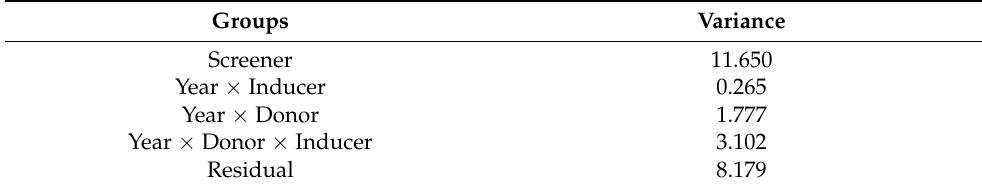
Table 2. Factors contributing to variance in the HIR.